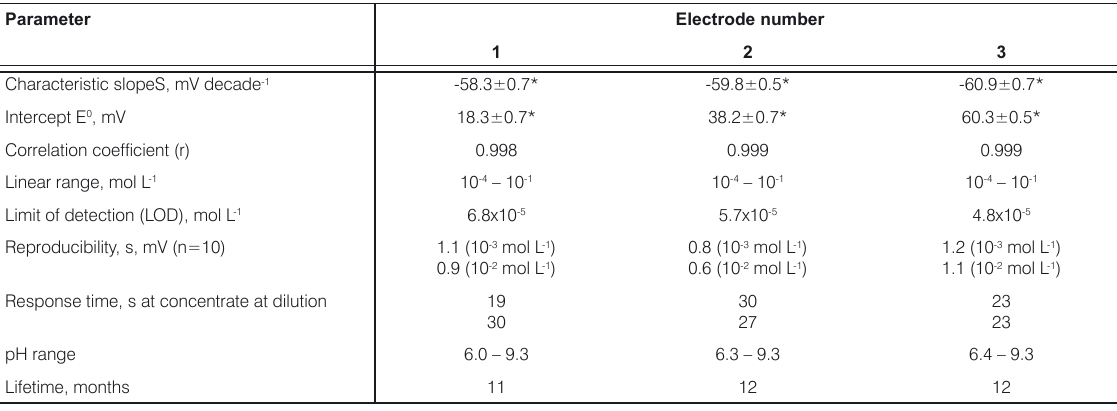
Table 2. Analytical parameters of ibuprofen electrodes based on TOA-Ibu complex.